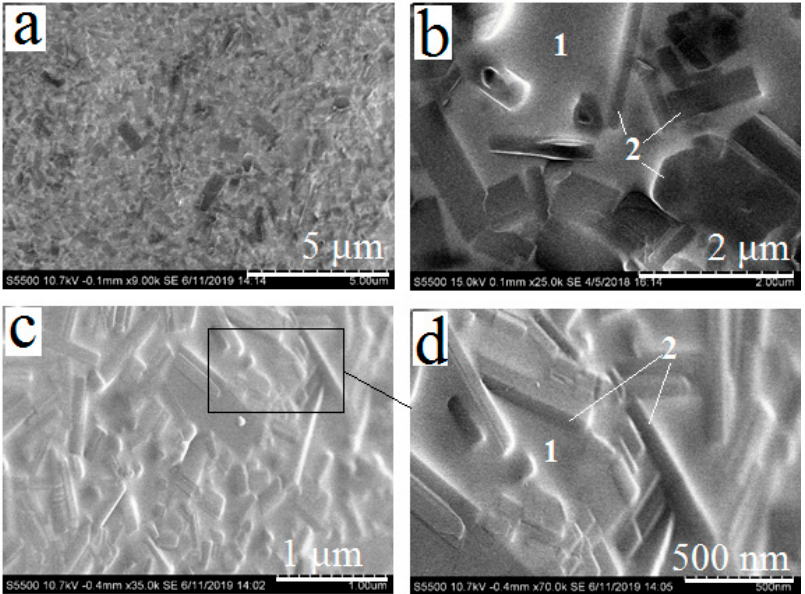
Table 1. Elemental composition of phases marked as 1 and 2 in Figure 4 b,d (at.%).